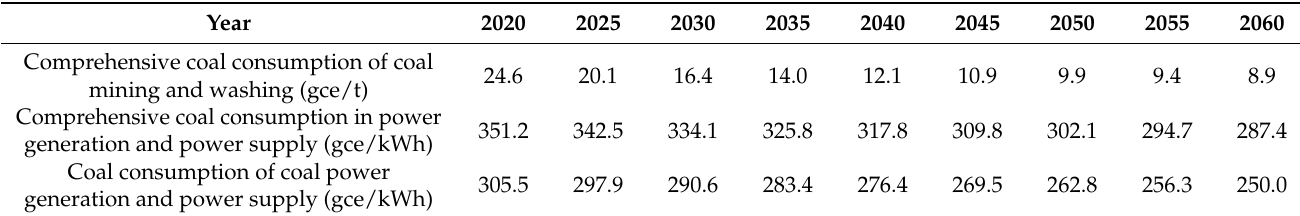
Table 2. Prediction of the future trend in comprehensive energy